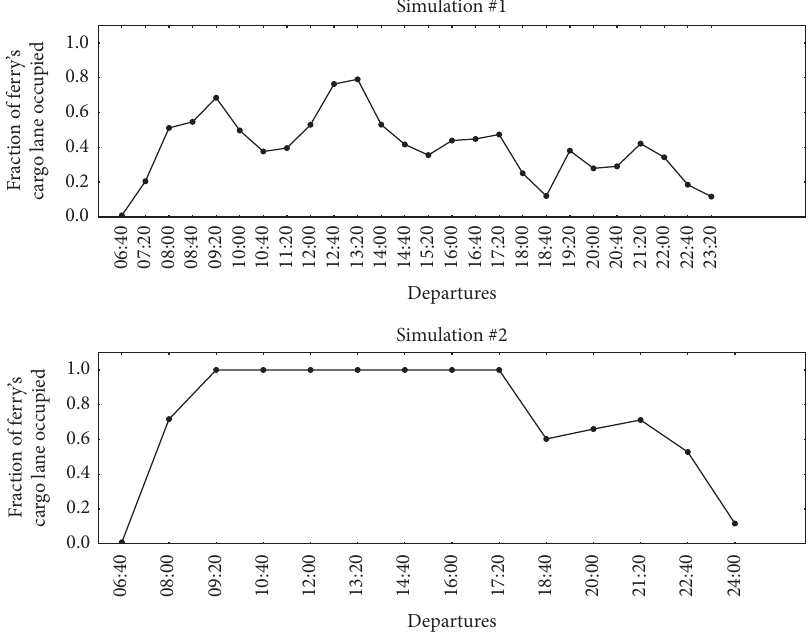
Figure 11: Length of ferry’s cargo lane occupied by vehicles for each run.